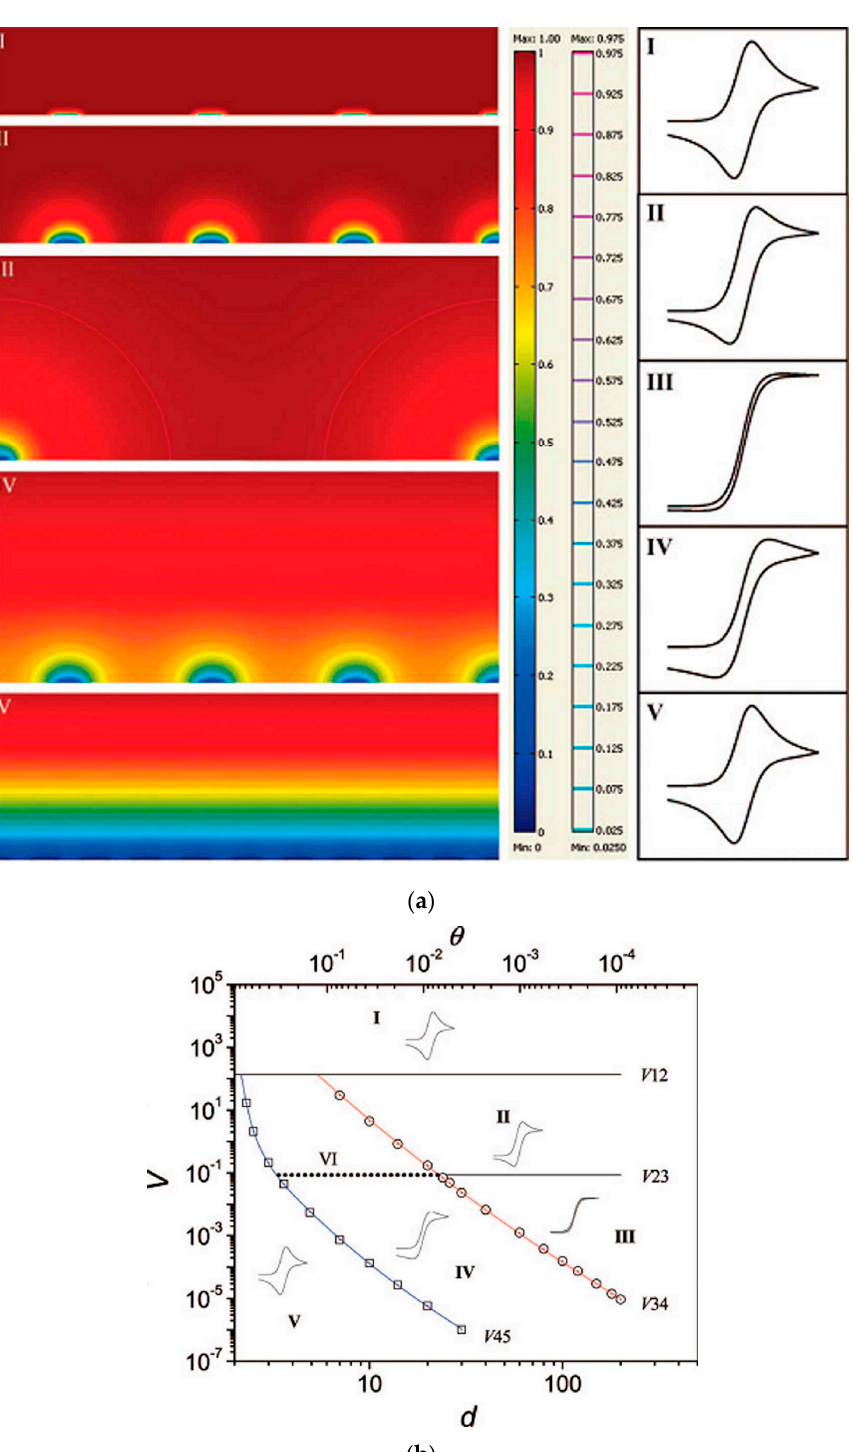
Figure 6. ( a ) Simulated concentration profiles and relevant voltammetric patterns, for microelectrode arrays representing the five main categories of possible diffusion modes (from I to V). In the scale bar, the red and blue colour represents the bulk concentration and zero concentration, respectively. The second scale bar represents a relative concentration scale for the contour lines. ( b ) Zone diagram of cyclic voltammetric behaviour at electrode arrays: d is the centre-to-centre distance of individual electrodes in the array (measured in units of a), V is the dimensionless scan rate, and θ is the fraction of electrochemically active area in the array (reprinted with permission from [64]).